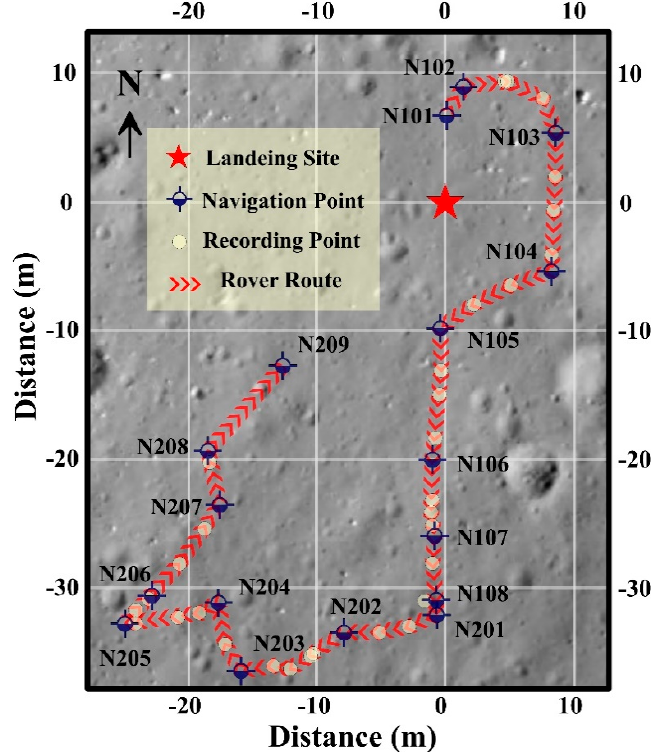
Figure 1. Walking track of Yutu. This picture has come from the descent camera on the Chang’E-3 (CE-3) lander.